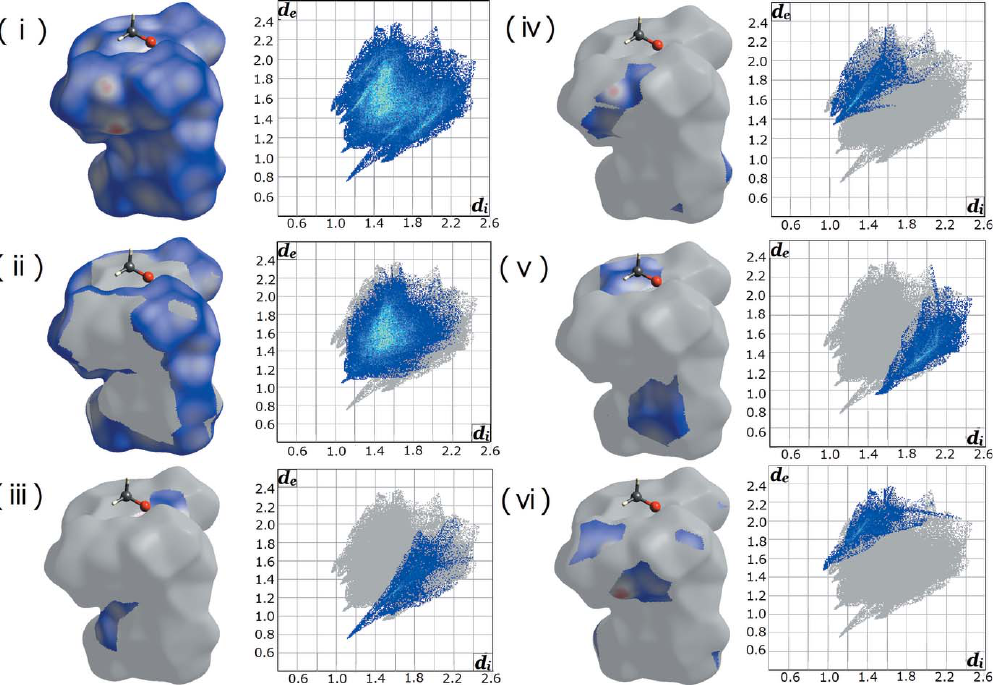
Figure 4 The three-dimensional Hirshfeld surface showing the intermolecular interactions plotted over d norm and the two-dimensional fingerprint plots of the title compound, showing (i) all interactions, and delineated into (ii) H (cid:2)(cid:2)(cid:2) H, (iii) O (cid:2)(cid:2)(cid:2) H, (iv) H (cid:2)(cid:2)(cid:2) O, (v) C (cid:2)(cid:2)(cid:2) H and (vi) H (cid:2)(cid:2)(cid:2) C interactions.